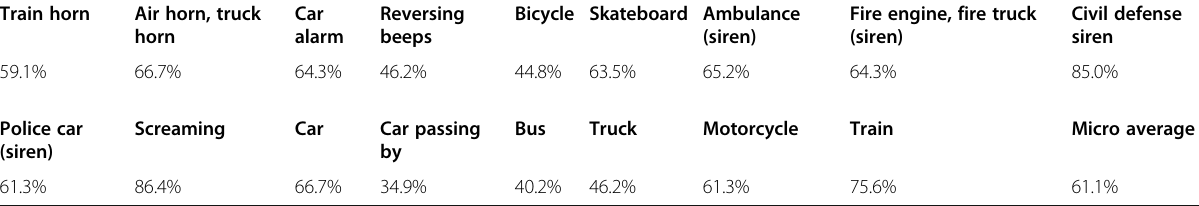
Table 8 F -score of audio tagging subtask for each event Train